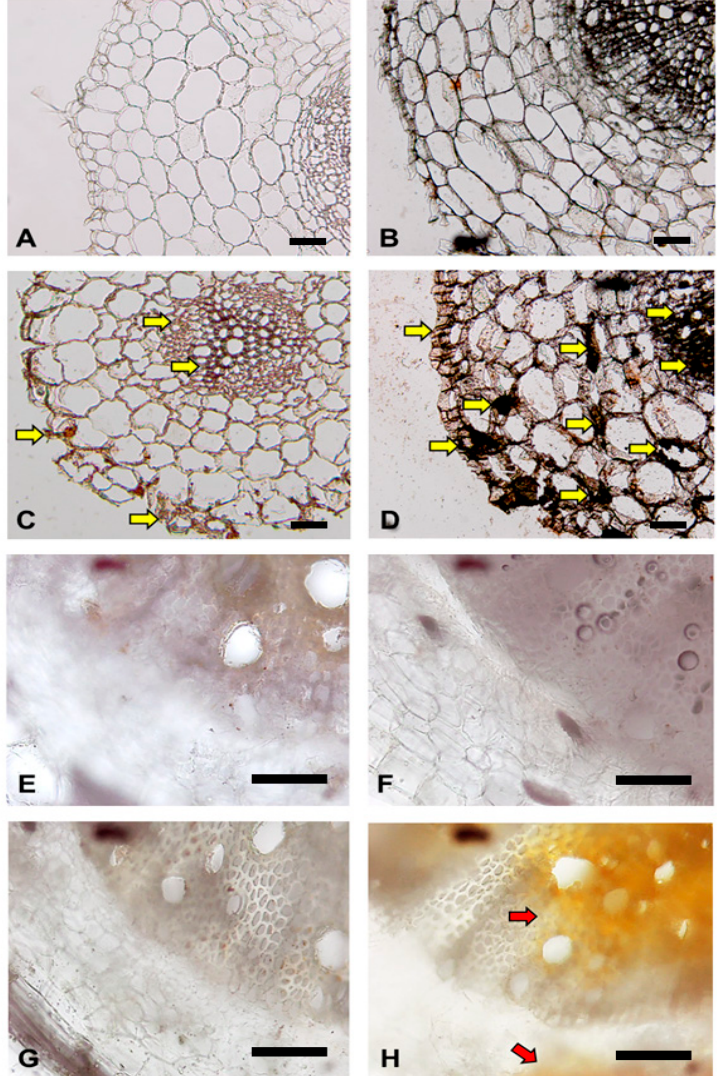
Figure 8. Immunomicroscopy of SlGRP4 protein ( A – D ) and detection of reactive oxygen species (ROS) ( E – H ) in tomato root tissues. ( A ) Control (no MgO treatment, no FOL inoculation), ( B ) tomato root 2 days after inoculation with FOL without MgO pretreatment, ( C ) tomato root treated with MgO NPs for 7 days (pretreatment only), ( D ) tomato root 2 days after inoculation with FOL with Mg NPs pretreatment, ( E ) control (no MgO treatment, no FOL inoculation), ( F ) tomato root 1 h after inoculation with FOL without MgO pretreatment, ( G ) tomato root treated with MgO NPs for 7 days (pretreatment only), and ( H ) tomato root 1 h after inoculation with FOL with Mg NPs pretreatment. Yellow arrows represent immuno-stained SlGRP4 proteins. Red arrows represent ROS (brown precipitate) detected by diaminobenzidine (DAB) staining. Scale bars represent 100 μ m.